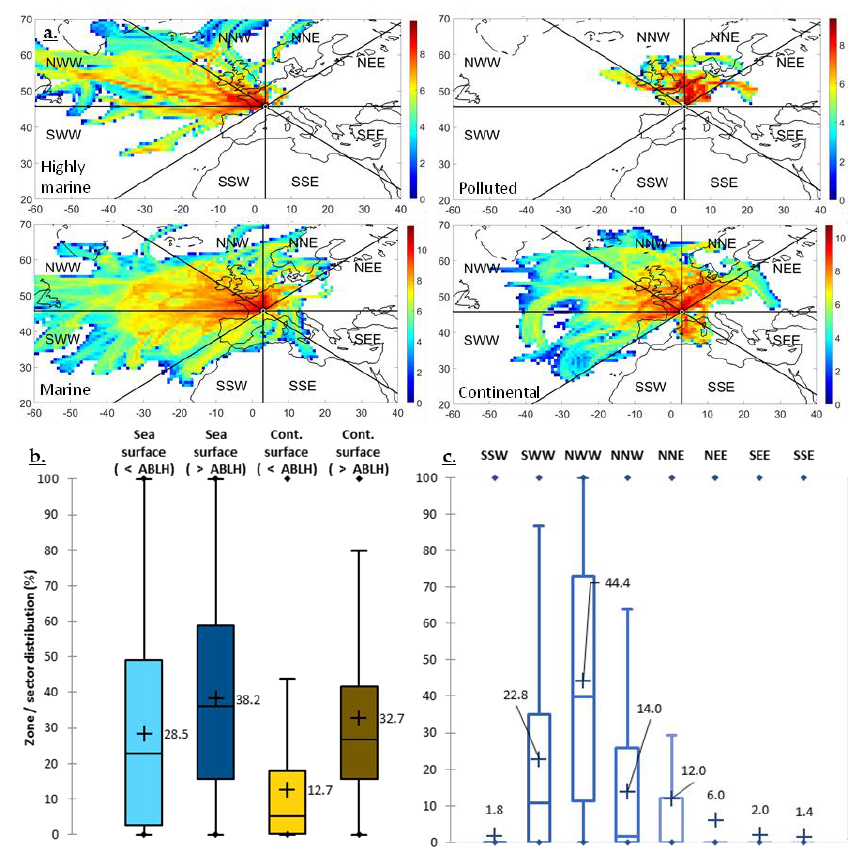
Figure 6. ( a ) Natural logarithm of the number of CAT (computing advection-interpolation of atmospheric parameters and trajectory tool) back trajectories points arriving at the summit of the PUY station per square of 0.8° size for “highly marine” (top left), “marine” (bottom left), “polluted” (top right), and “continental” (bottom right) categories. The black lines separate the different sectors. Distributions of the parameters evaluated by the CAT model for all the 295 cloud events; ( b ) Percentage of the time spent over the “sea surface” (blue) and “continental surface” (brown), in pale blue and pale brown below the atmospheric boundary layer height (<ABLH) and dark above in the free troposphere (>ABLH); ( c ) Percentage of the time spent in the 8 forty-five degrees sectors (NNE, ENE, ESE, SSE, SSW, WSW, WNW and NNW). One box plot per zone/sector is displayed. The black crosses correspond to the means. The central horizontal bars are the medians. The lower and upper limits of the box are the first and third quartiles, respectively. The ends of whiskers are 10th and 90th percentiles. Black diamonds are minimum and maximum for each species.